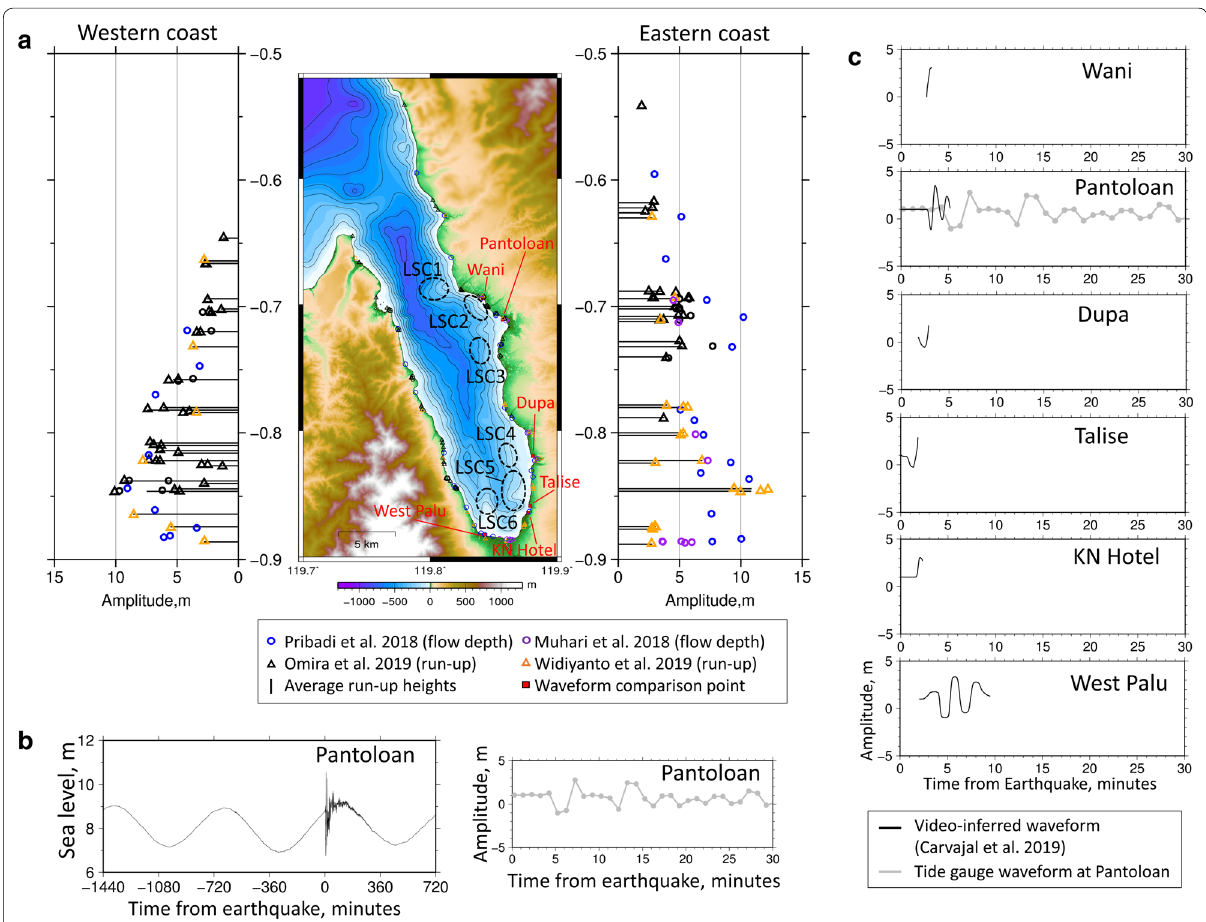
Fig. 1 Tsunami observations in the Palu Bay area. a Bathymetric (contour interval 100 m) and topographic map of Palu Bay. Field survey points shown in the map are tsunami flow depths [blue circles, Pribadi et al. (2018); purple circles, Muhari et al. (2018)] and run-up heights [black triangles, Omira et al. (2019); orange triangles, Widiyanto et al. (2019)]. Waveform comparison points are locations where the tsunami waveform was inferred from the Pantaloan tide gauge (see b ) or from video footage [see c ; Carvajal et al. (2019)]. Landslide candidates (LSC1 to LSC6, dashed ellipses; see text) are also shown. The left and right graphs show flow depths and run-up heights on the western and eastern coasts, respectively, and black bars indicate average run-up heights over intervals of 0.002° latitude. b The observed tsunami waveform at the Pantoloan tide gauge: left, the two-day waveform including the earthquake origin time, and right, the waveform (with tidal contributions removed) during the 30 min following the earthquake. c Video-inferred tsunami waveforms from Carvajal et al. (2019). The waveform at the Pantaloan tide gauge (gray curve from b ) is shown for